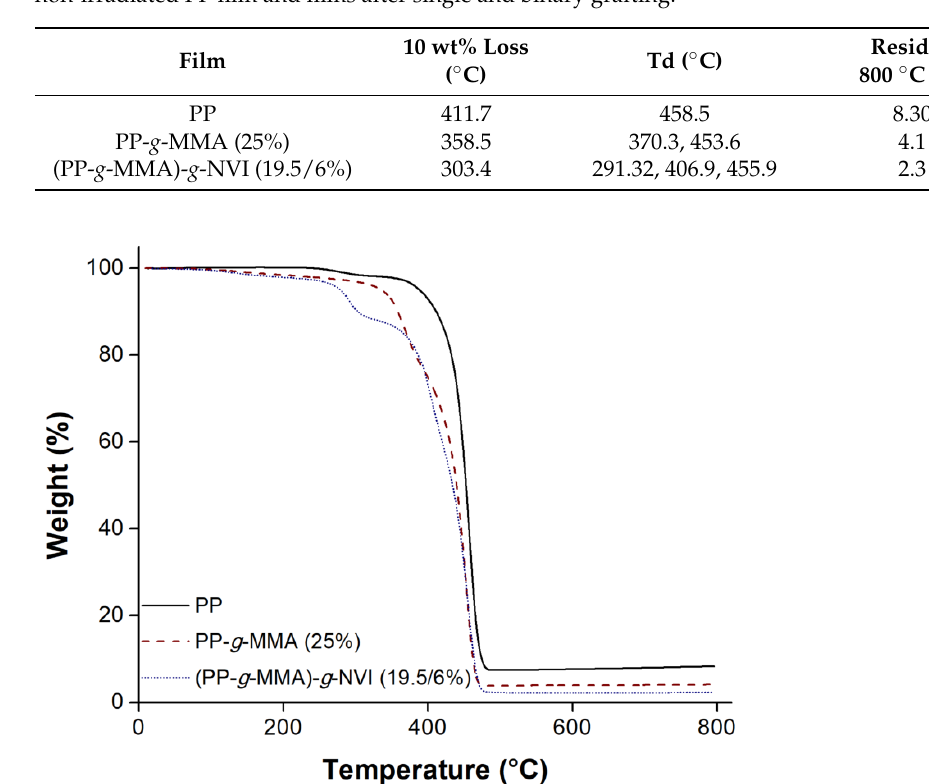
Table 2. Results of TGA (weight loss, decomposition temperature, residue) analyses of pristine non-irradiated PP film and films after single and binary grafting.